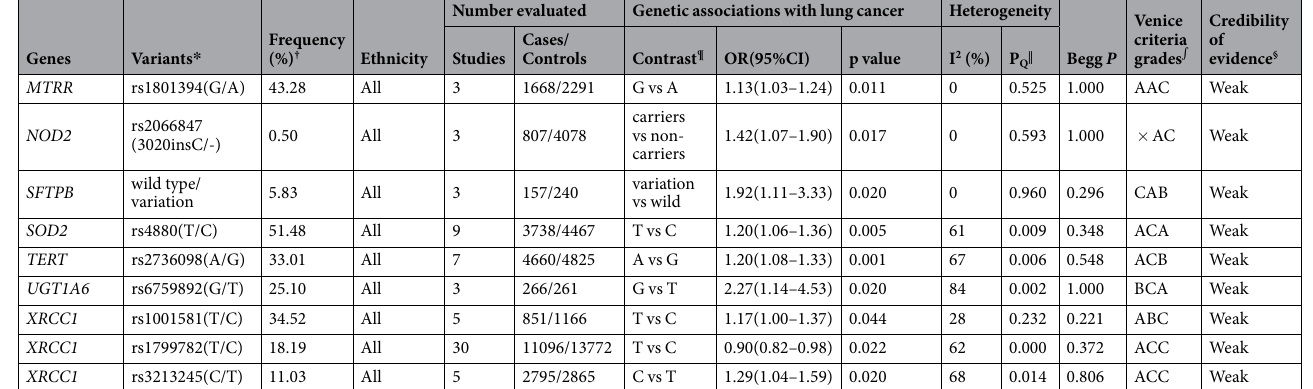
Smoking status. As for subgroup meta-analyses by smoking status, significant associations were found for twenty-two variants and ten variants in the smokers and the non-smokers, respectively. In the smoker population, the significant associations only showed moderate ( APEX1 rs1760944, CYP1A1 rs4646903, CYP2A6 non * 4/ * 4, CYP2E1 rs6413432, CYP2E1 rs2031920, GSTP1 rs1138272, and NBN rs1805794) or weak cumulative evidence, mostly due to lack of large-scale evidence and the presence of potential biases (Table 3, Supplementary Table S8). In the non-smokers populations, the significant associations had strong, moderate, or weak evidence for one two groups, seventeen were unique to the smoking population, five to the non-smoking population, and five shared between the two populations (Supplementary Fig. S5). Functional annotations. Based on main and subgroup meta-analyses, a total of 22 variants showed signif- icant associations to lung cancer susceptibility with strong cumulative evidence. We further performed genomic annotations for these variants using HaploReg v4.1 25 , which can help to predict the functional variants. Of them, twelve variants are located in exon, two in microRNA (miRNA), and the others in non-coding regions (four intronic, two intergenic, one 5 ′ UTR, and one 3 ′ UTR) (Table 4). Most of these variants are located within enhancer or promoter elements that are active across a wide range of tissue types (including lung cancer or normal lung tissues). Furthermore, majority of these 22 variants have been identified as expression quantitative trait loci (eQTLs) of a number of genes in various tissue types including normal lung tissues. The functional potential of ten non-synonymous SNPs were further predicted using PolyPhen-2 26 . The variant rs351855 may result in a probably damaging effect on FGFR4 function. The other non-synonymous SNPs were predicted to be “benign”. Non-significant associations. Non-significant associations for 150 variants within 98 genes were found under any genetic model (allelic, dominant, or recessive model) in both main and subgroup meta-analyses (Supplementary Table S9). Among these 150 variants, credibility of cumulative epidemiological evidence were identified as strong, moderate, or weak for seven ( ERCC1 rs16979802, ERCC1 rs2298881, ERCC1 r s735482, POLI